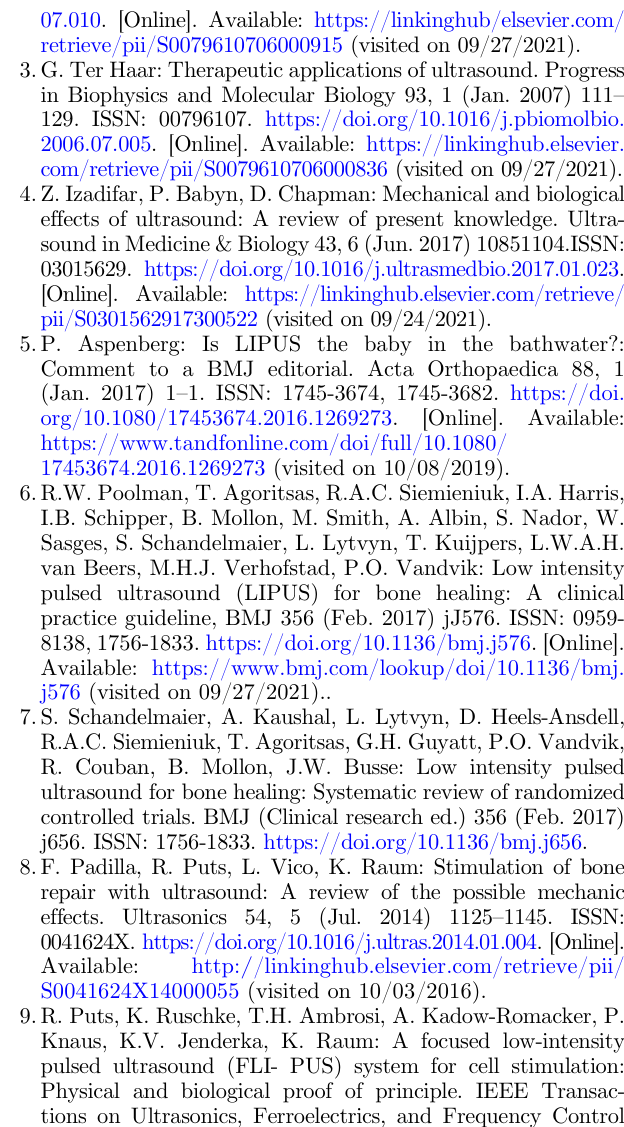
Table 6. Analytical calculation of the intensity and loss for the 2.25 MHz-transducer. Intensity of the wave Measured at 36 mm (under the Petri dish) Measured at 39 mm (above the Petri dish) Calculated after 3 Runs in water Transmitted into the Petri dish Calculated after 3 Runs in the bottom